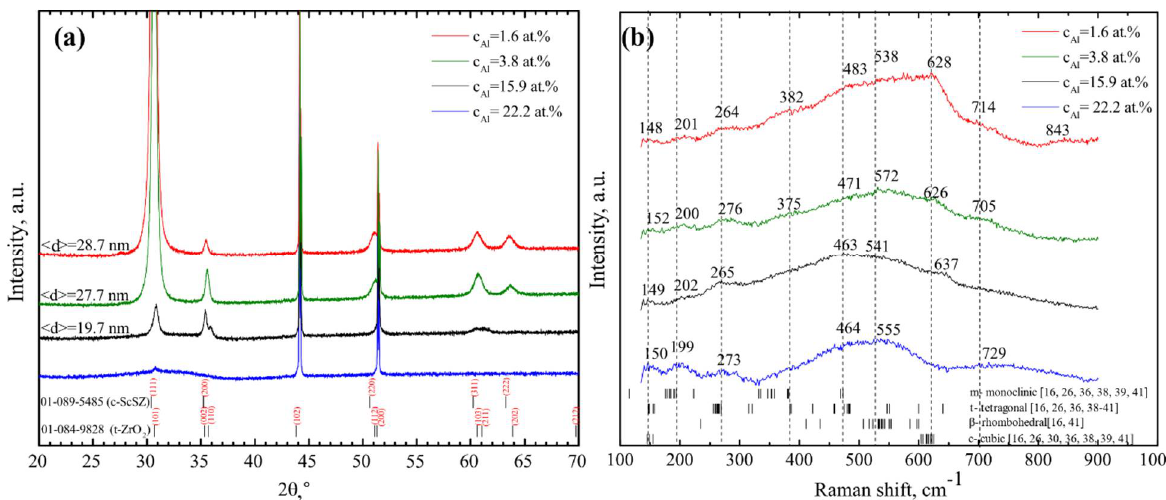
Figure 3. ( a ) XRD patterns and ( b ) Raman spectra of ScAlSZ thin films. The Raman spectroscopy measurements of ScAlSZ supplemented the XRD analysis.